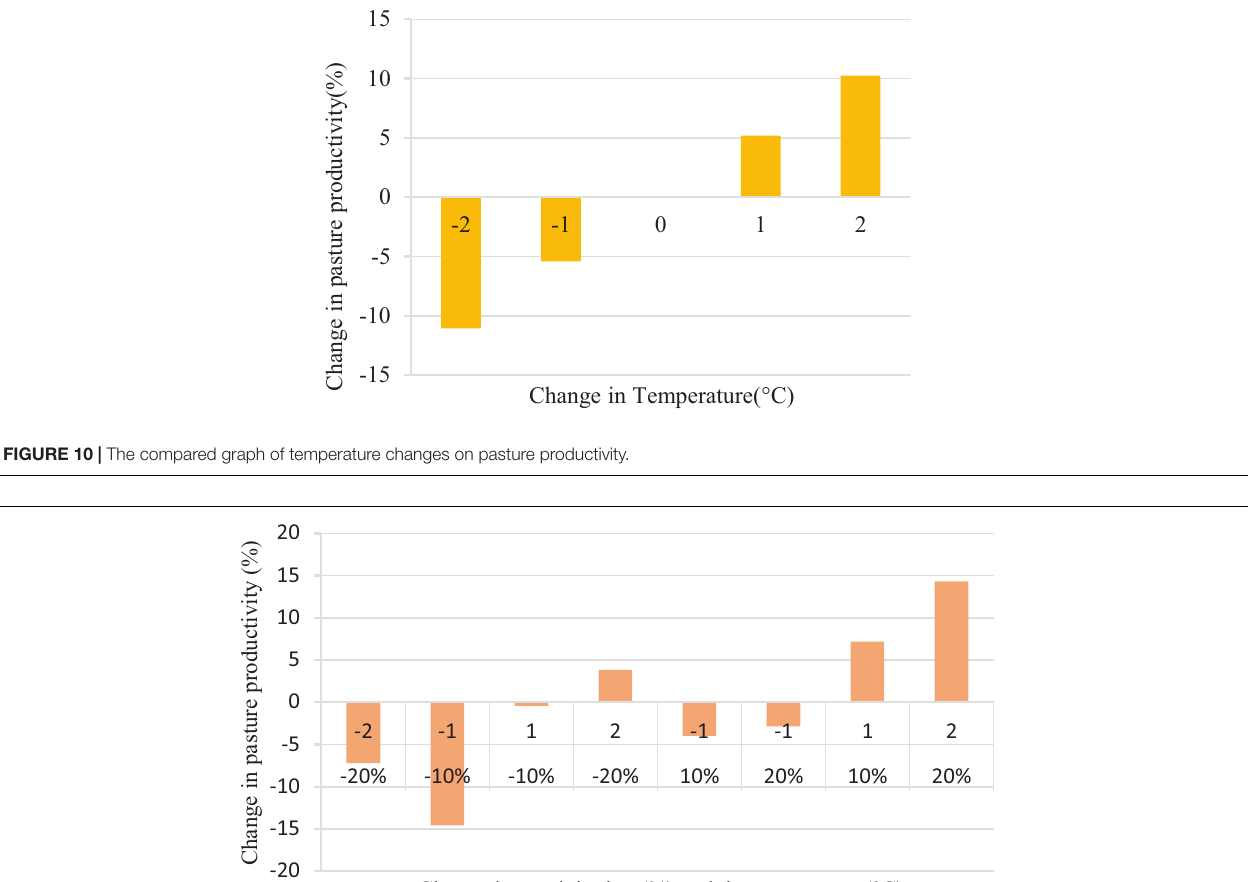
Change in precipitation (%) and in temperature(°C) FIGURE 11 | The compared graph of precipitation and temperature changes on pasture productivity.